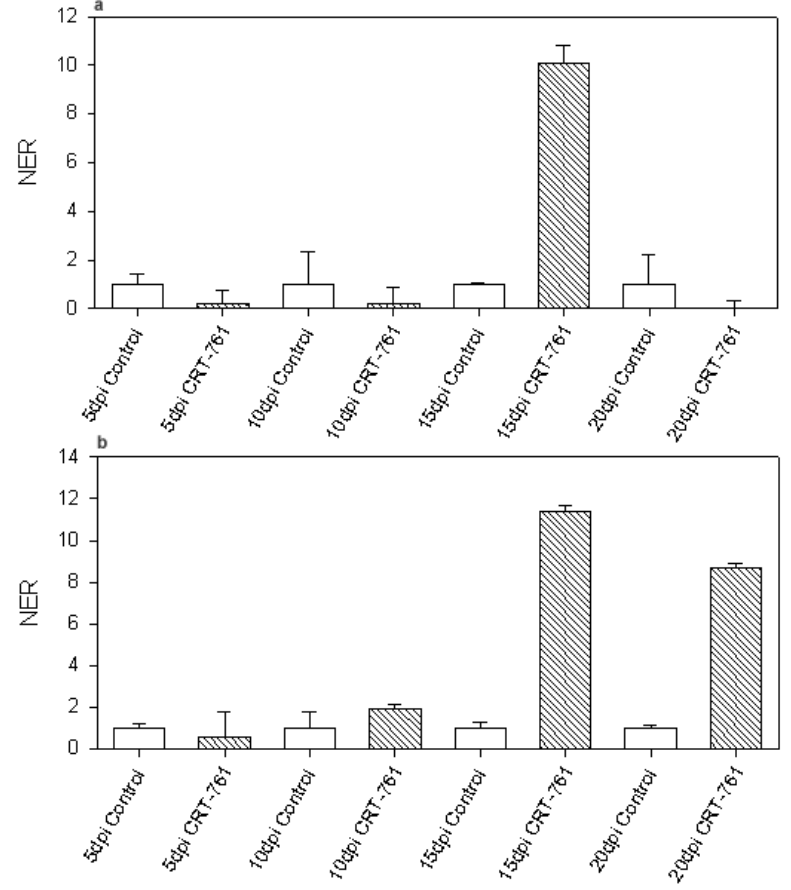
Figure 6. Mi-eri-1 transcript level in parasitic stages. Normalized expression rate (NER) of Mi-eri-1 at 5, 10, 15 and 20 days post infection (dpi). White bars represent Mi-eri-1 transcript levels in nematodes soaked in control siRNA. Striped bars represent Mi-eri-1 transcript levels in nematodes soaked in siRNA CRT-761 before inoculation. ( a ) J2s were soaked for 1 hour in siRNA in water, washed and incubated for 16 hours in water before infection; ( b ) J2s were soaked for 1 hour in siRNA in the presence of 3% lipofectamine and 25 mM glutamate, washed and incubated for 16 hours in water before infection. For each time point, the results are from technical triplicates done on one first strand cDNA templates obtained from one RNA extractions. Error bars: Standard error of the mean